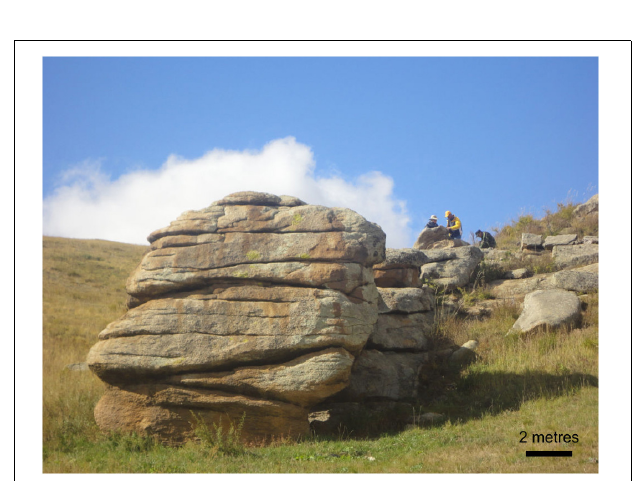
FIGURE 4 | Photo showing a typical outcrop of the biotite granite of the Tukhum pluton (photo courtesy of Yo.